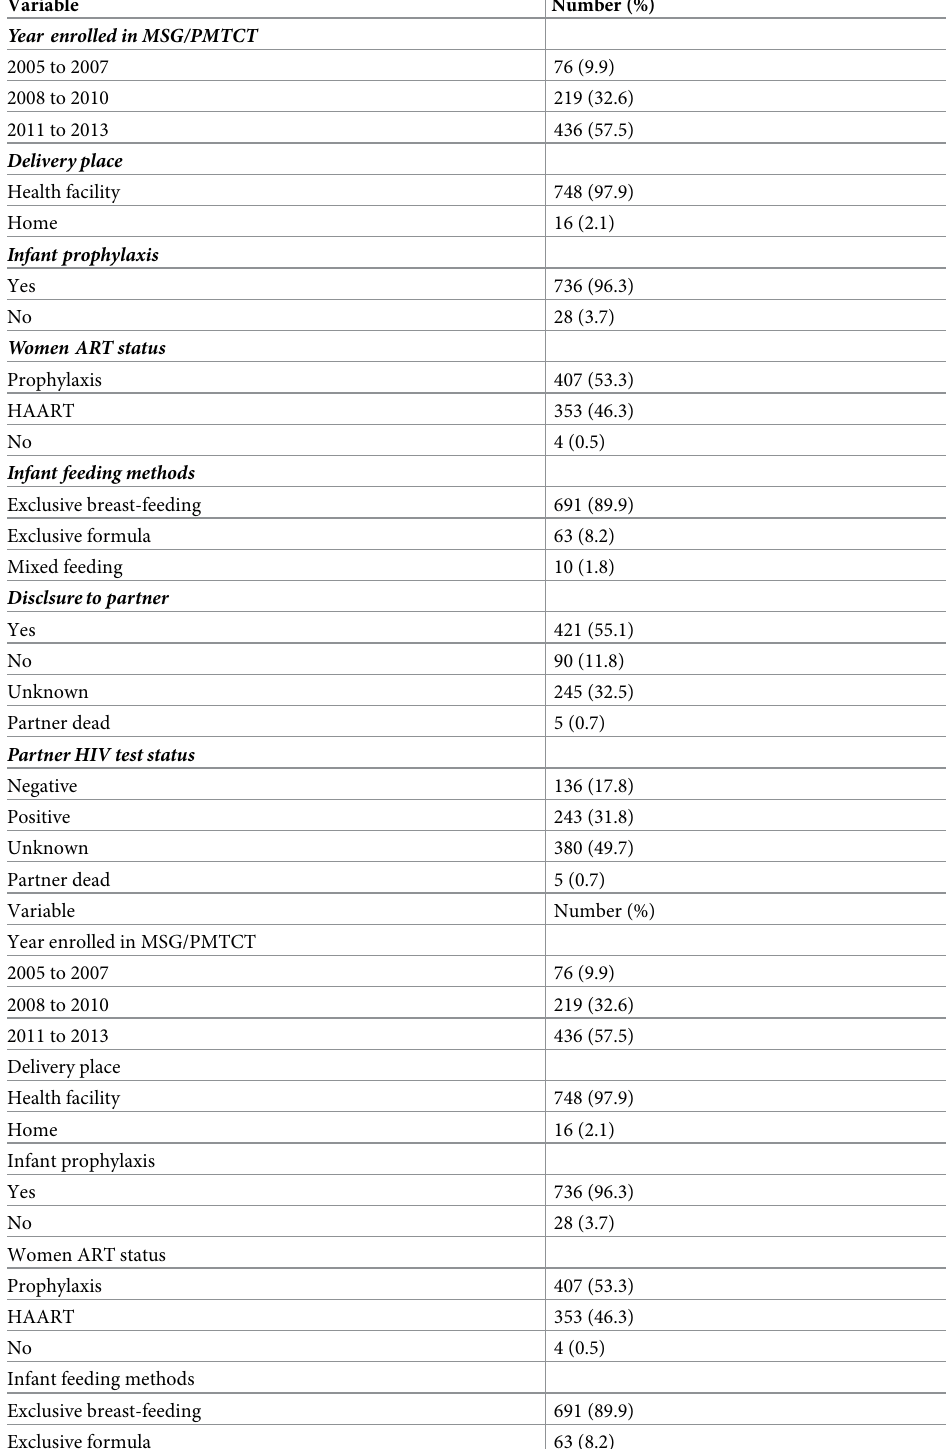
Table 2. Characteristics of women and HIV exposed babies enrolled in MSG programmes from 2005 to 2013, Addis